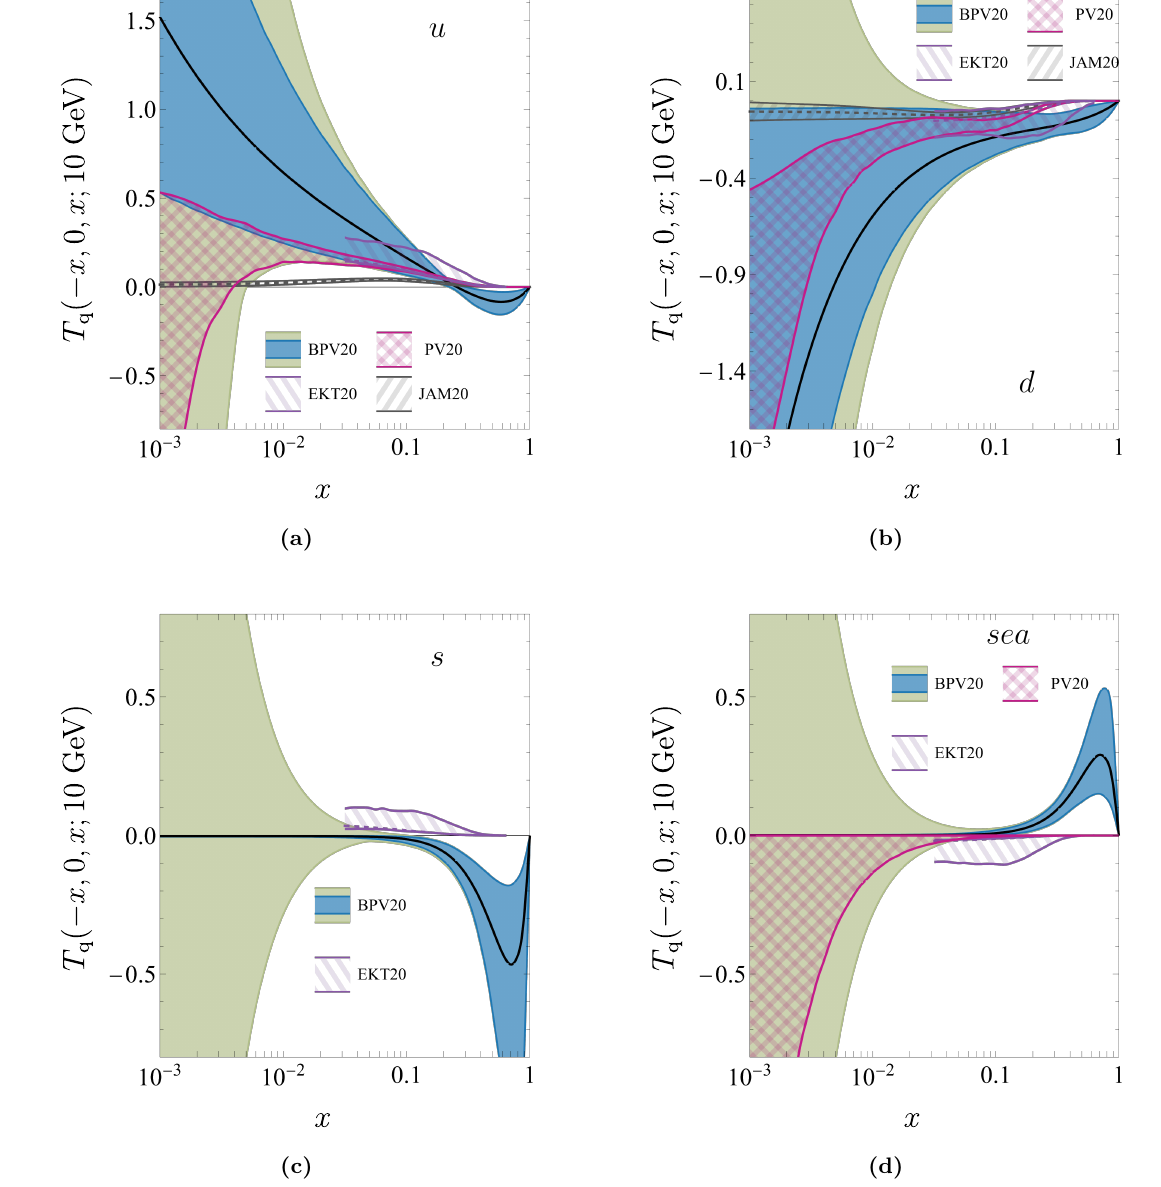
+ | T ) as described in the text. Our d | u |